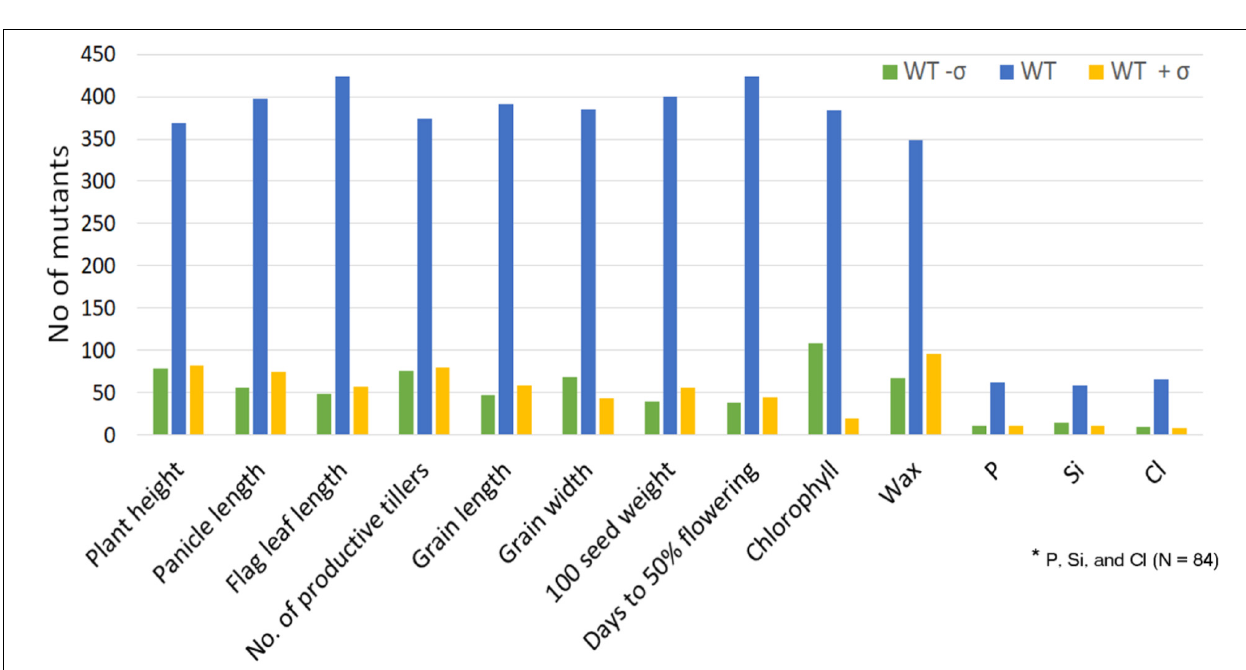
FIGURE 6 | SNP distribution across different genic regions in the mutants.